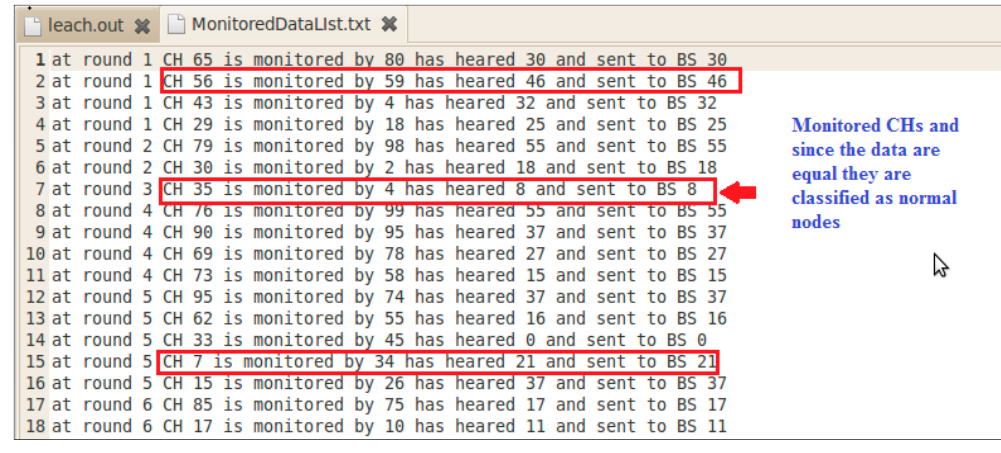
Figure 15. Monitoring report.